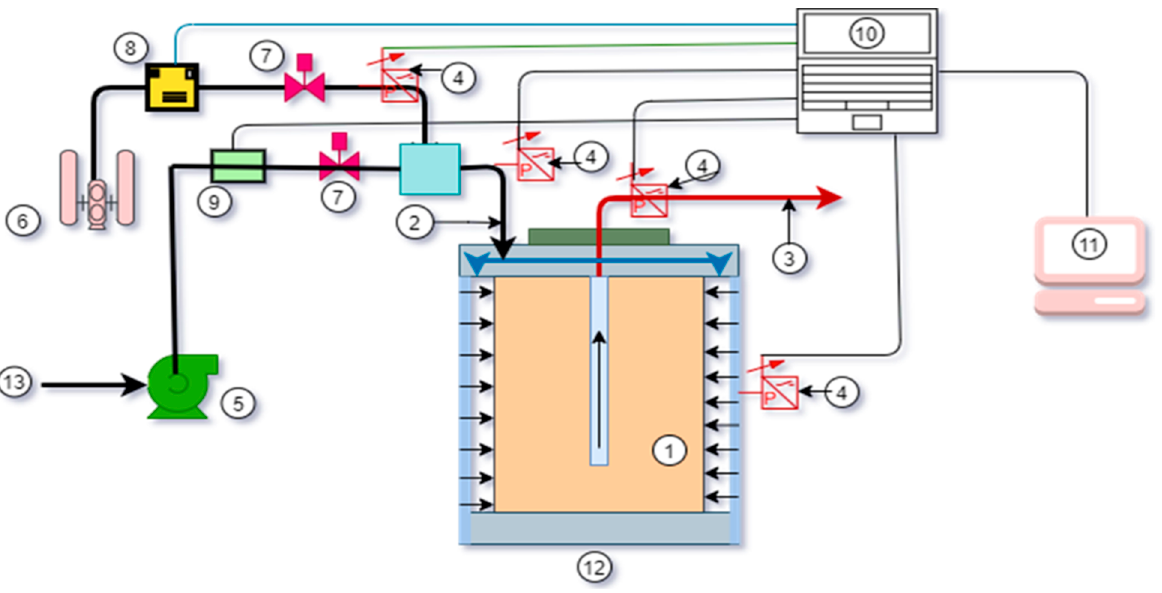
Figure 2. Schematic diagram of the experiment R.F.C. facility: 1. Sample, 2. Inlet, 3. Outlet, 4. Pressure Sensors, 5. Water pump, 6. Air compressor, 7. non-Return valves, 8. Airflow meter, 9. Water flowmeter, 10. Data Acquisition, 11. Computer, 12. Samples Chamber, 13. Waterline.